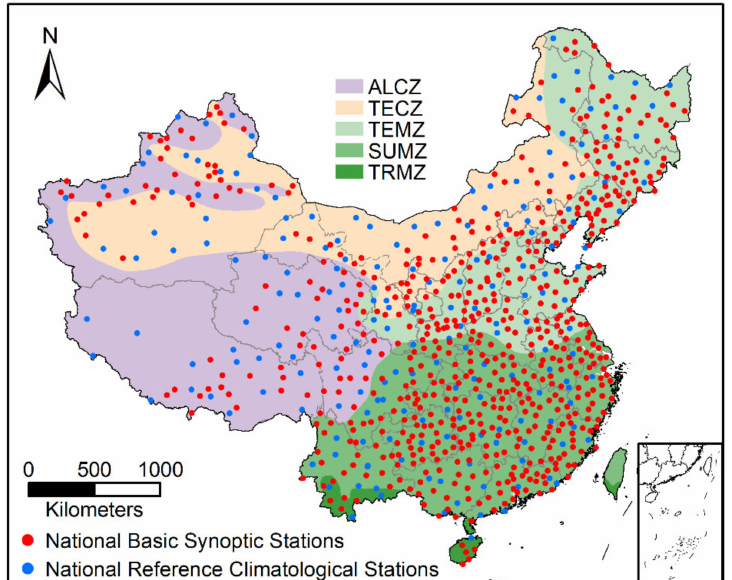
Figure 1. China’s five main climate zones: the alpine climate zone (ALCZ), the temperate continental climate zone (TECZ), the temperate monsoon climate zone (TMCZ), the subtropical monsoon climate zone (SUMZ) and the tropical monsoon climate zone (TRMZ), and the distribution of 822 national surface weather stations in